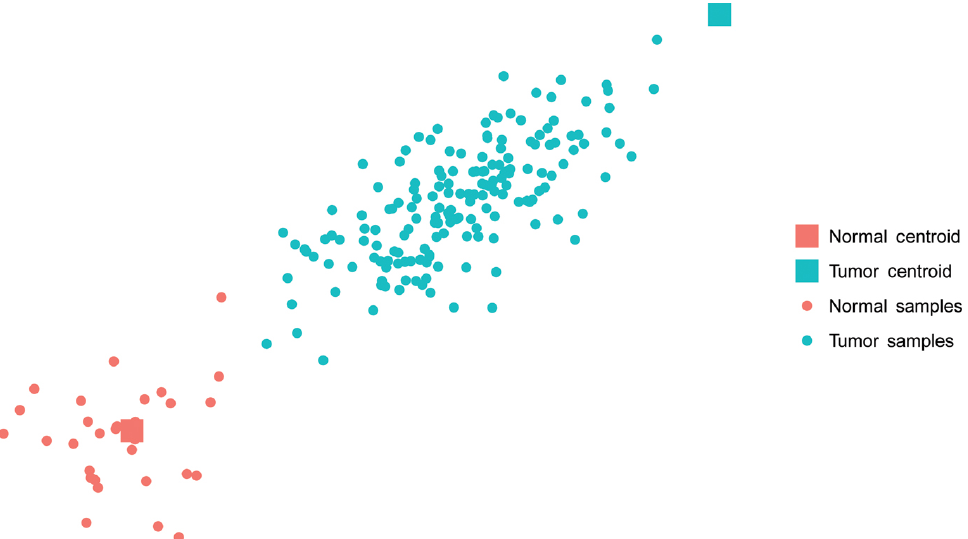
Figure 1: Example of the model in a 2-dimensional space using simulated data. The normal tissue samples belong to an ordinary normal distribution with “ Normal Centroid ” as mean. The tumor samples produce an elongated shape because impurity drags them towards the normal tissue